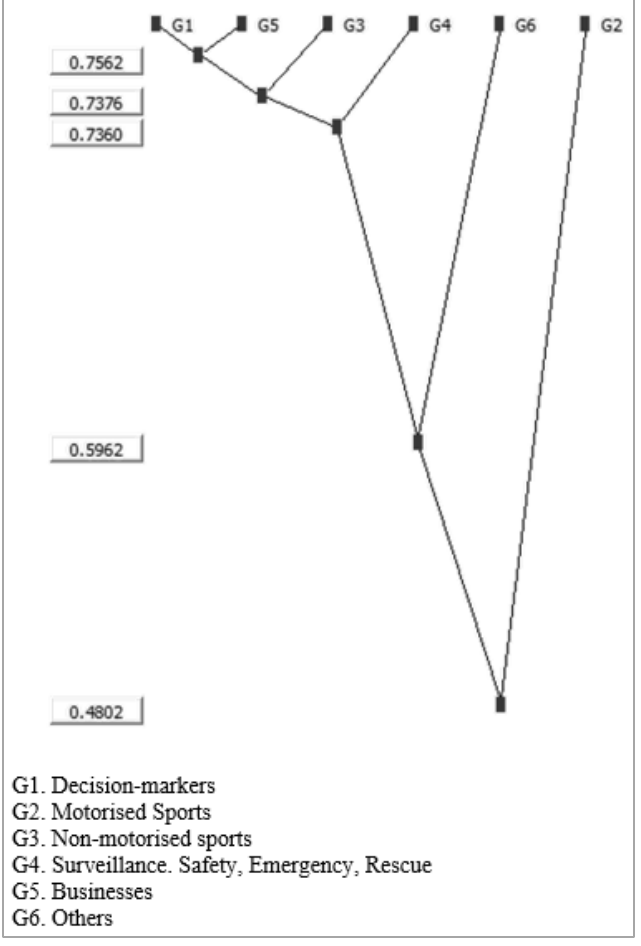
Figure 5. Dendrogram of stakeholder groups on the forest planning